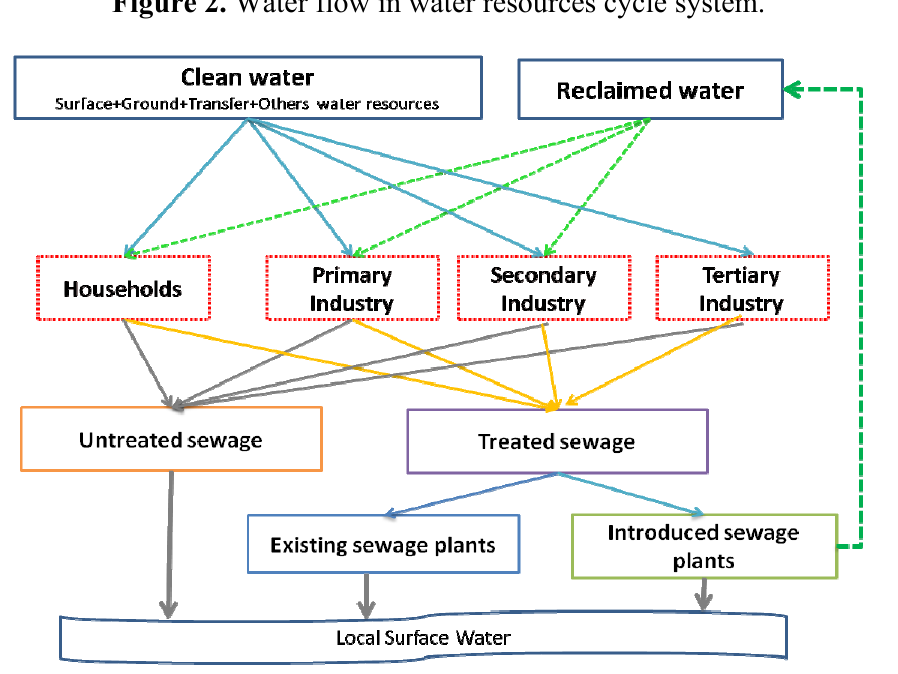
Figure 2. Water flow in water resources cycle